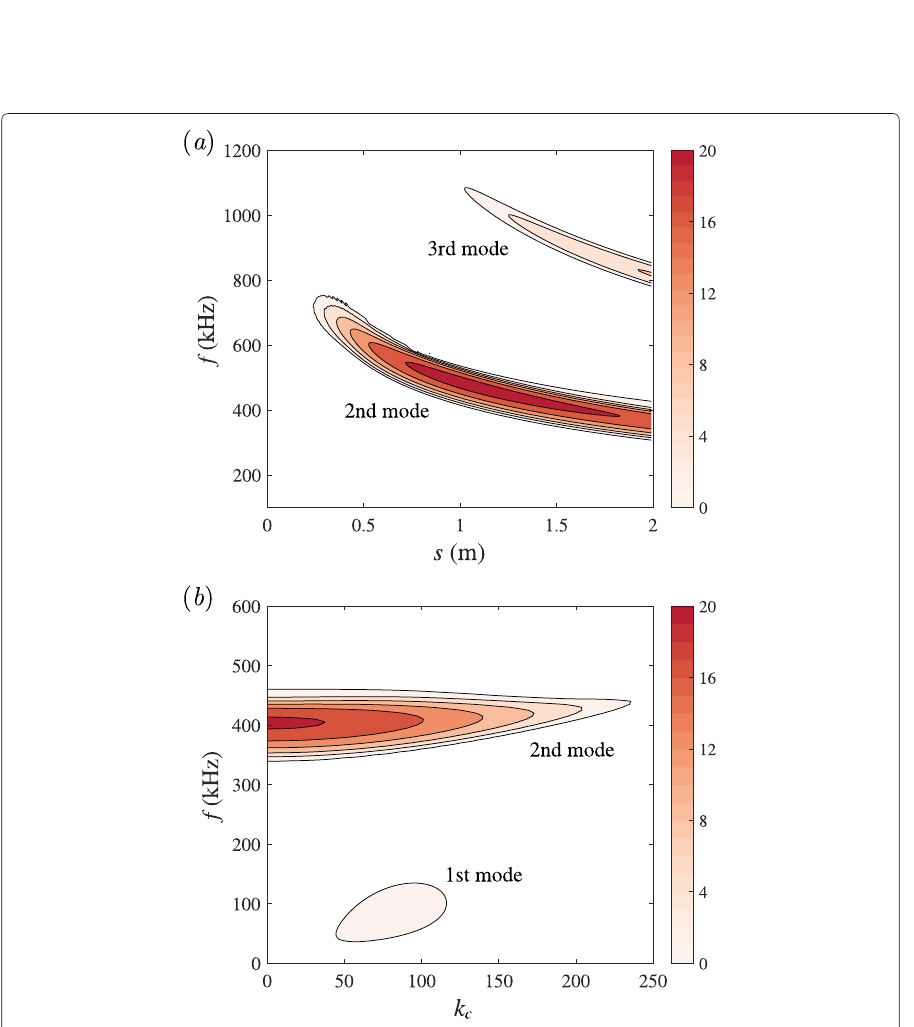
Fig. 3 Growth rate contours ( − α i , 1 / m ) ( a ) for axisymmetric waves and ( b ) with the azimuthal wavenumber at s =